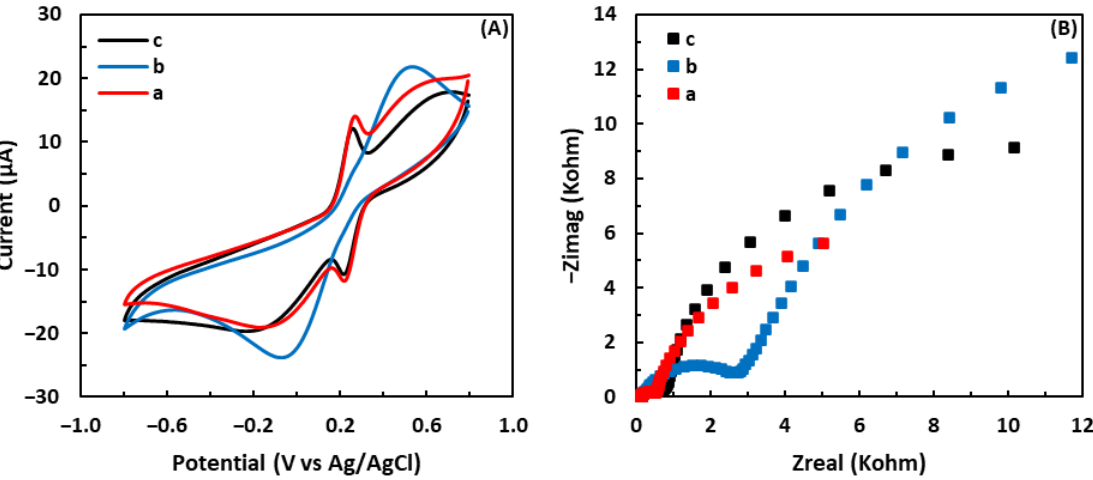
Figure 8. ( A ) Cyclic voltammograms and ( B ) Nyquist plots of (a) the GSH-modified electrode before being treated with the Fenton reagent, (b) after being treated with the Fenton reagent, and (c) after regenerated by NADPH and GR in 5 mM solution of [Fe(CN) 6 ] 3 − /4 − containing 0.1 M KCl.